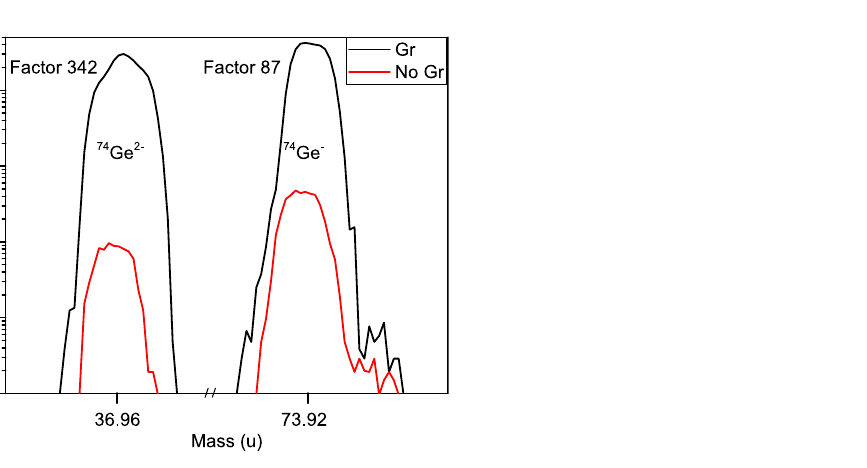
Figure 2. A comparison of mass spectra of the germanium substrate with and without graphene layer for optimal GESIMS conditions. The intensity of the SIMS signal can be enhanced more than two orders of